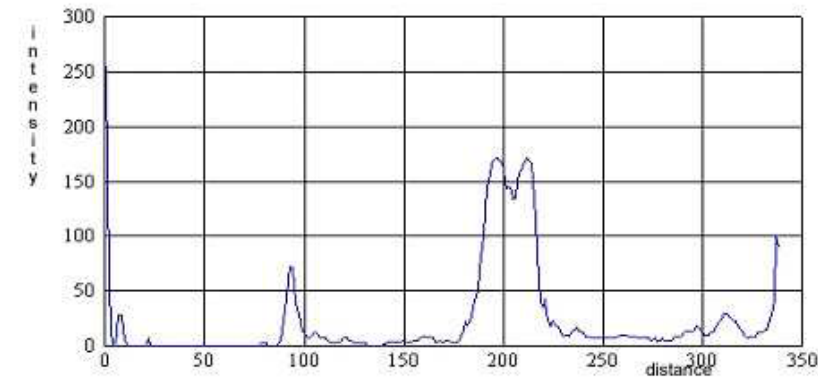
Figure 1 . The SDS-PAGE pattern of the untreated reconstituted skim milk on 12.5 % gel; 1. 2. Reconstituted skim milk (the sample without and the sample with 2-mercaptoethanol, respectively), 3. α –La, 4. κ -casein, 5, 6. β -Lg, 7. β -casein, 8. Molecular weight standards. The SDS-electrophoretic – profile of the soluble skim milk proteins (Fig.1, line 1) contains five major bands identified as α s casein, b -casein, α –La, 71 kDa-band, and three minor bands identified as β -Lg, κ -casein and 141 kDa- bands. According to the densitometric analysis (Fig. 2), the five major soluble components represent 83.71% of the soluble protein fraction. Furthermore, the content of the casein fraction and α –La is 69.86% and 6.92%, respectively.